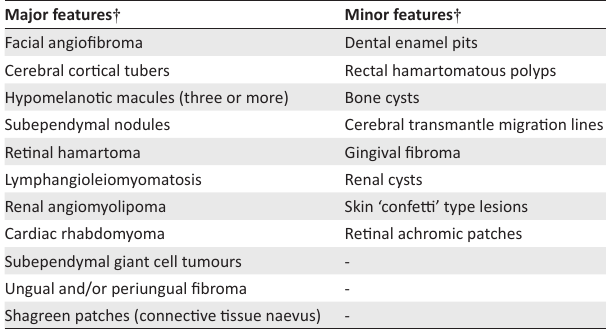
FIGURE 7: MR angiography image of the circle of Willis. TABLE 1: Typical major and minor features of tuberous